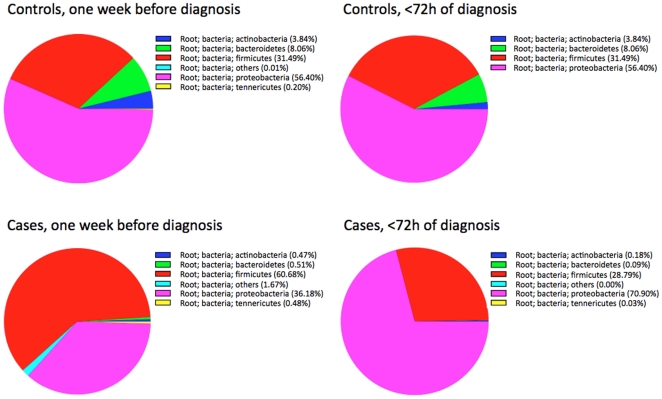
Changes in proportion of bacterial phyla.Proportions of the four major phyla in nine controls and nine cases one week before and within 72 hours of NEC diagnosis.